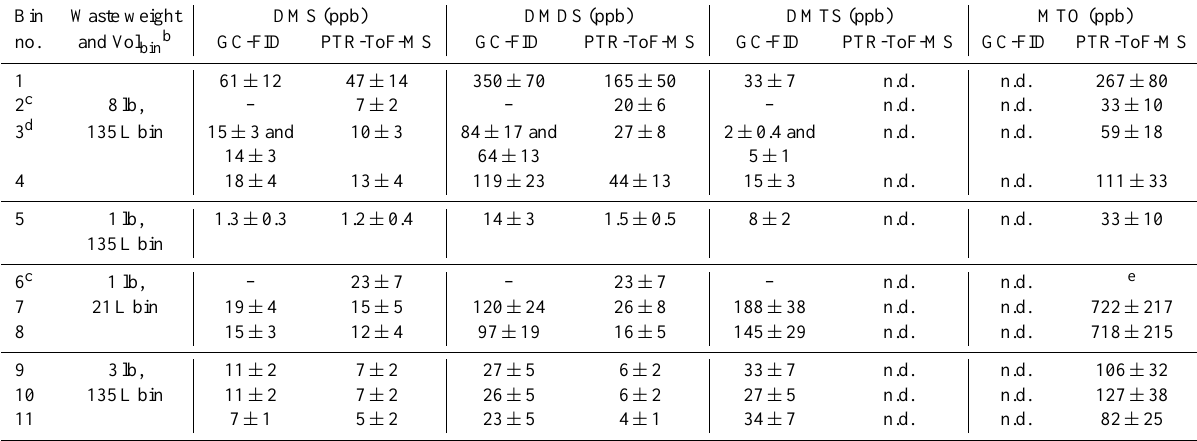
Table 2. Results from source samples – intercomparison between PTR-ToF-MS and GC-FID analysis a . Bin Waste weight DMS (ppb) DMDS (ppb) DMTS (ppb) MTO (ppb) no. and Vol binb GC-FID